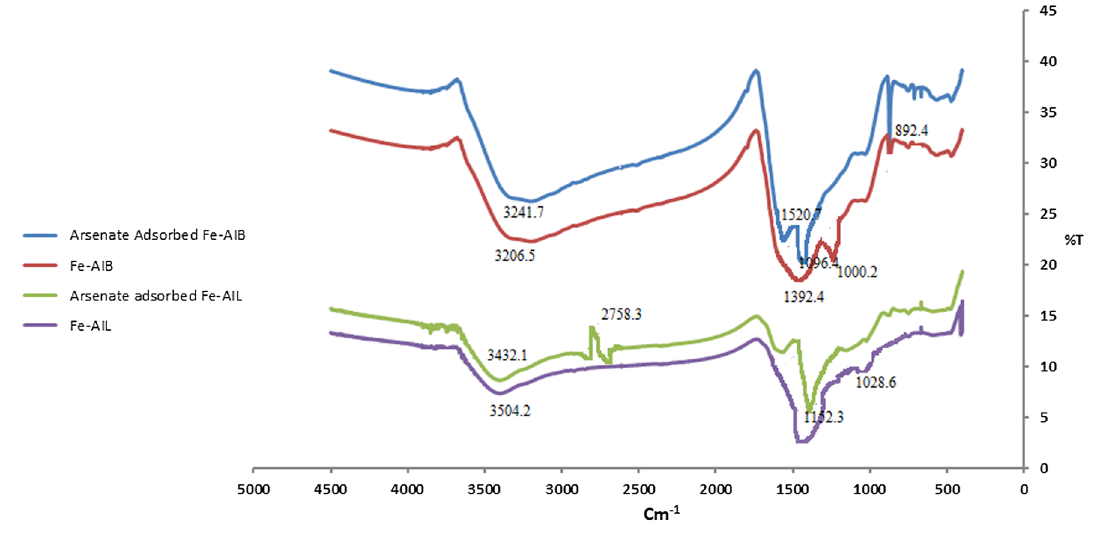
Fig. 7 FTIR spectra of Fe-AIB and Fe-AIL before and after adsorption